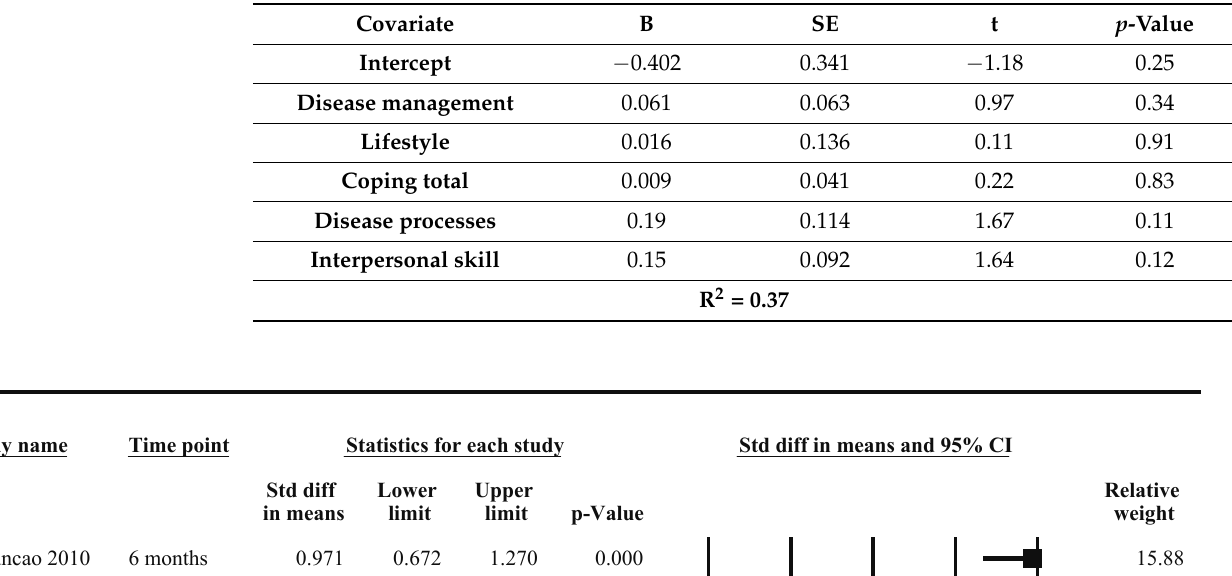
Table 2. Association of effect size of TPE interventions (for biomedical outcomes) with content of interventions.